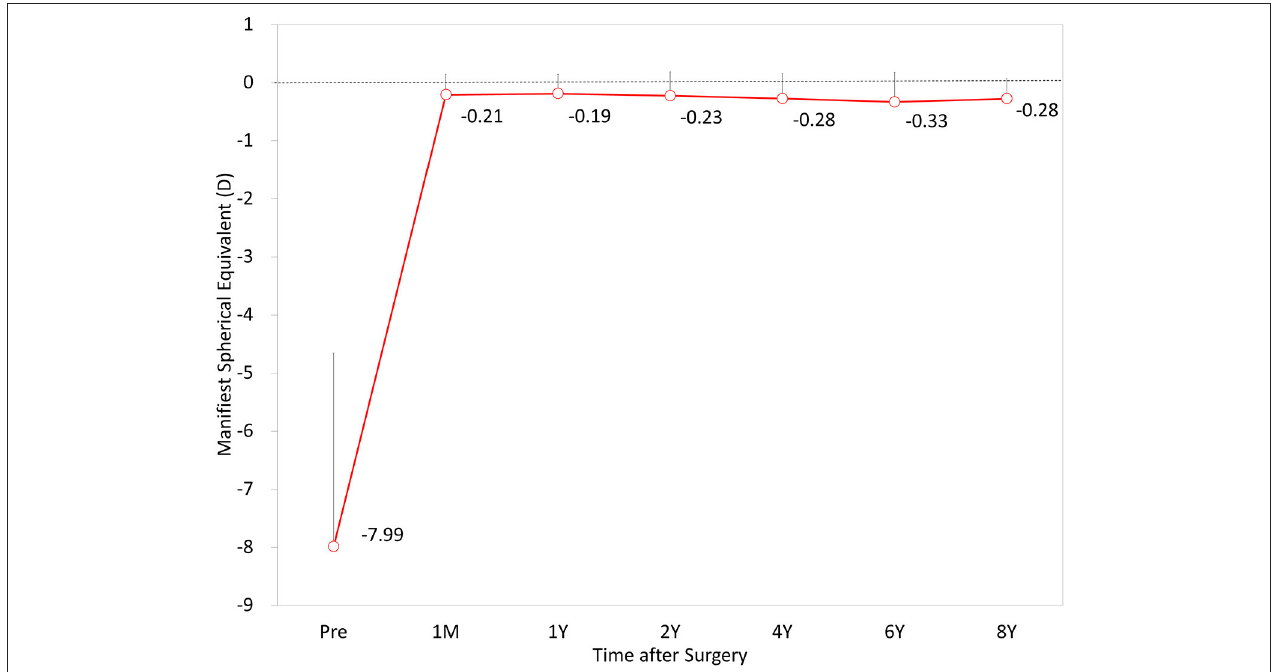
FIGURE 4 | Time course of manifest spherical equivalent (MSE) after hole implantable collamer lens (EVO-ICL) implantation.